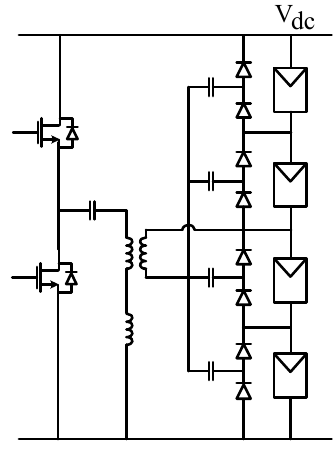
Figure 24. Series resonant voltage equalizer [53].